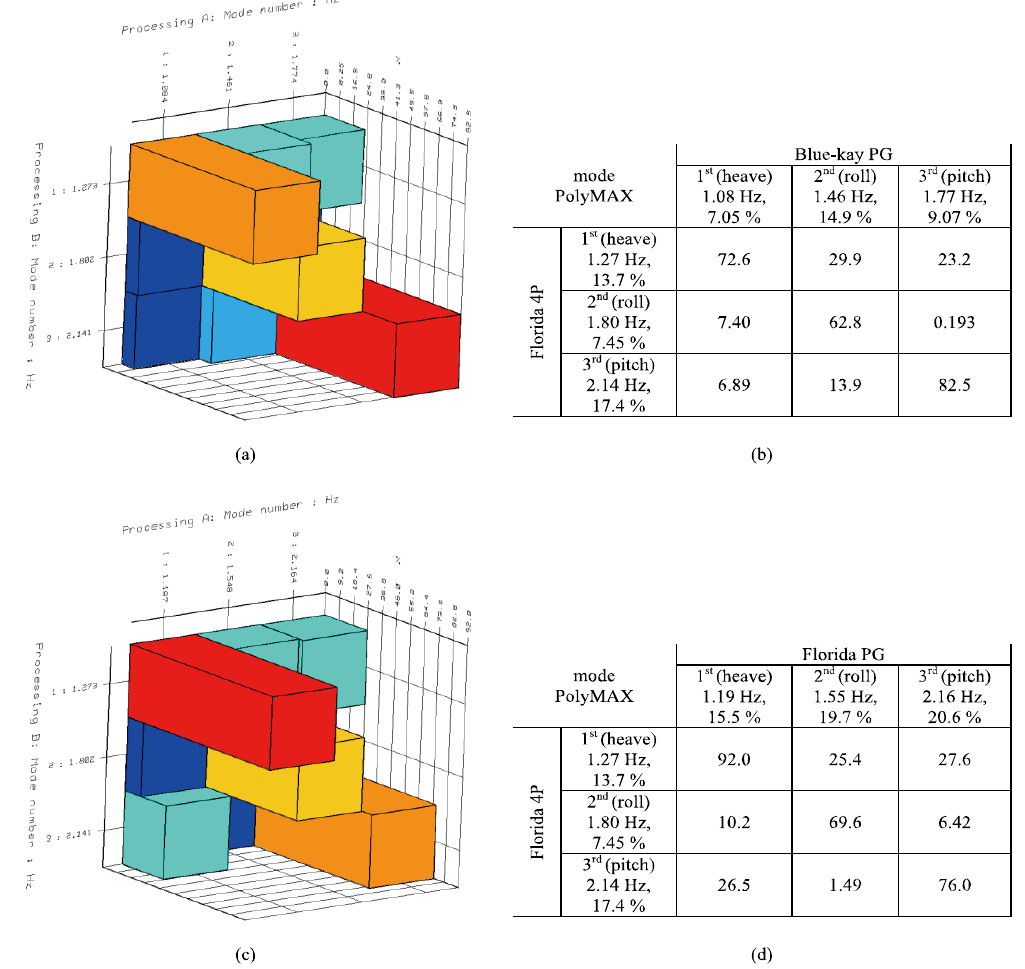
Fig. 8. Semi-active suspension car: MAC matrix and table in the cases (a, b) Blue-kay, proving ground and Florida, four poster and (c, d) Florida, proving ground and Florida, four